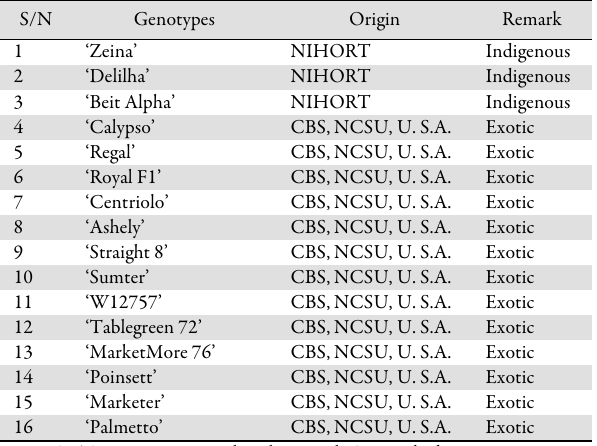
Table 1. Origins and source of cucumber collection for the carried out